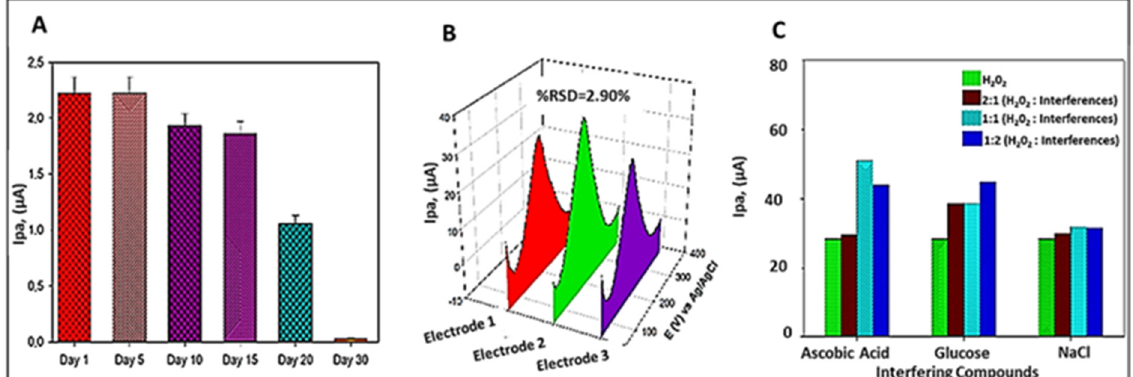
Figure 6. ( A ) Stability of electrodes—Bar diagram with error bars representing the changes in current obtained after storing for weeks; ( B ) 3D DPV graph showing reproducibility of the method, ( C ) Interference studies—Bar diagram showing changes in current obtained after adding different ratios of interfering species.